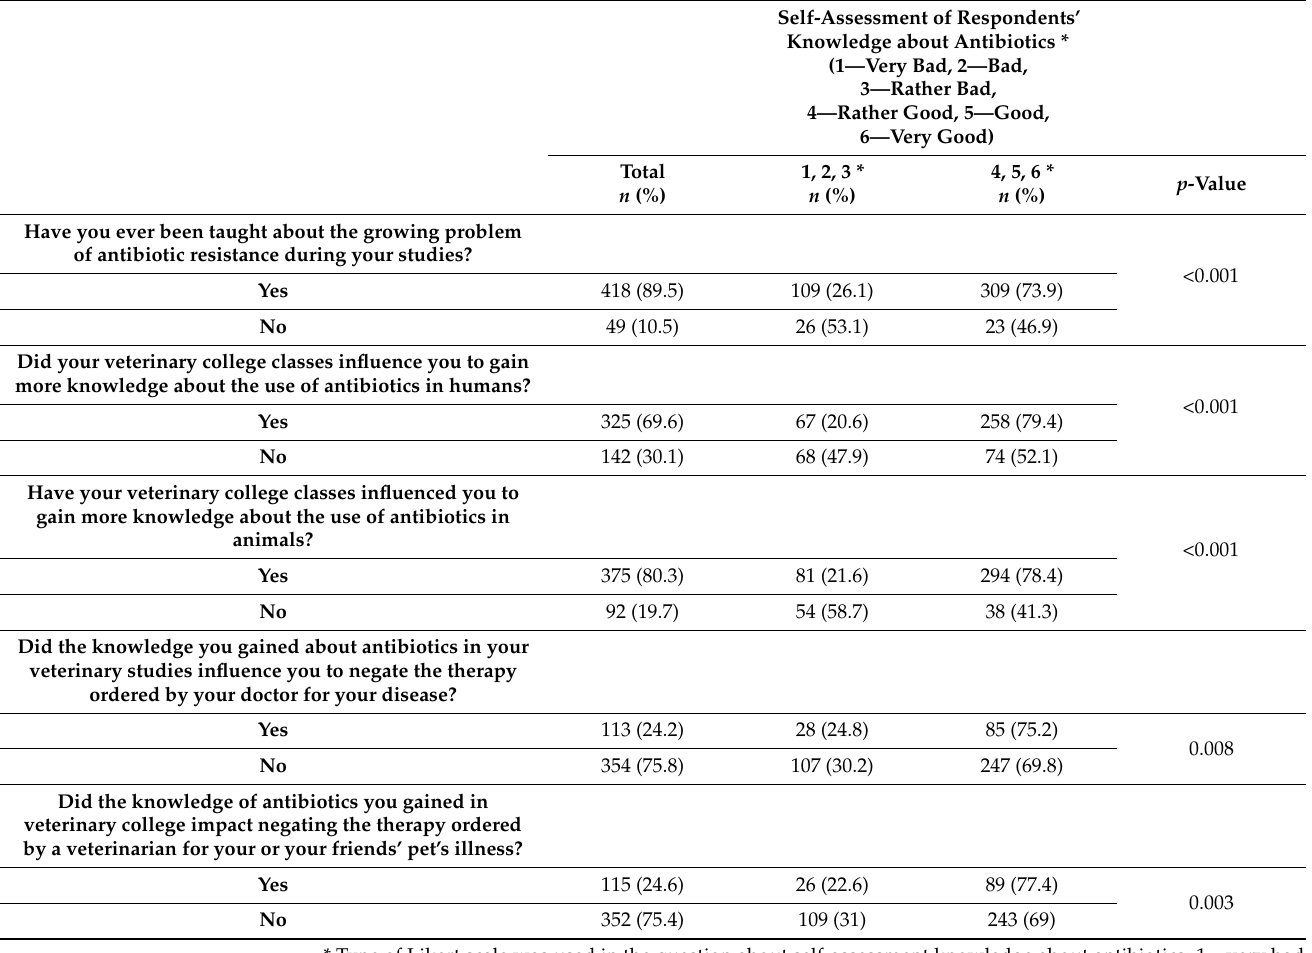
Table 3. Effect of college curriculum on attitudes toward antibiotic use and the phenomenon of antibiotic resistance ( n =